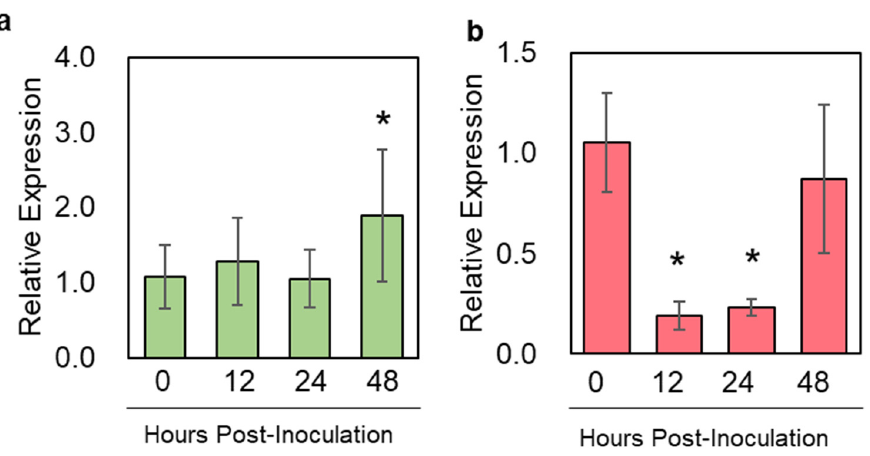
Figure 2. Expression of SQUALENE SYNTHASEs in N. benthamiana and S. lycopersicum upon P. infestans inoculation. Relative expression of NbSQS ( a ) and SlSQS ( b ) upon P. infestans inoculation. Error bars = standard deviation statistically significant differences from the mock ‐ inoculated control group indicated by * ( p < 0.005, Student’s t ‐ tests; N = 6).